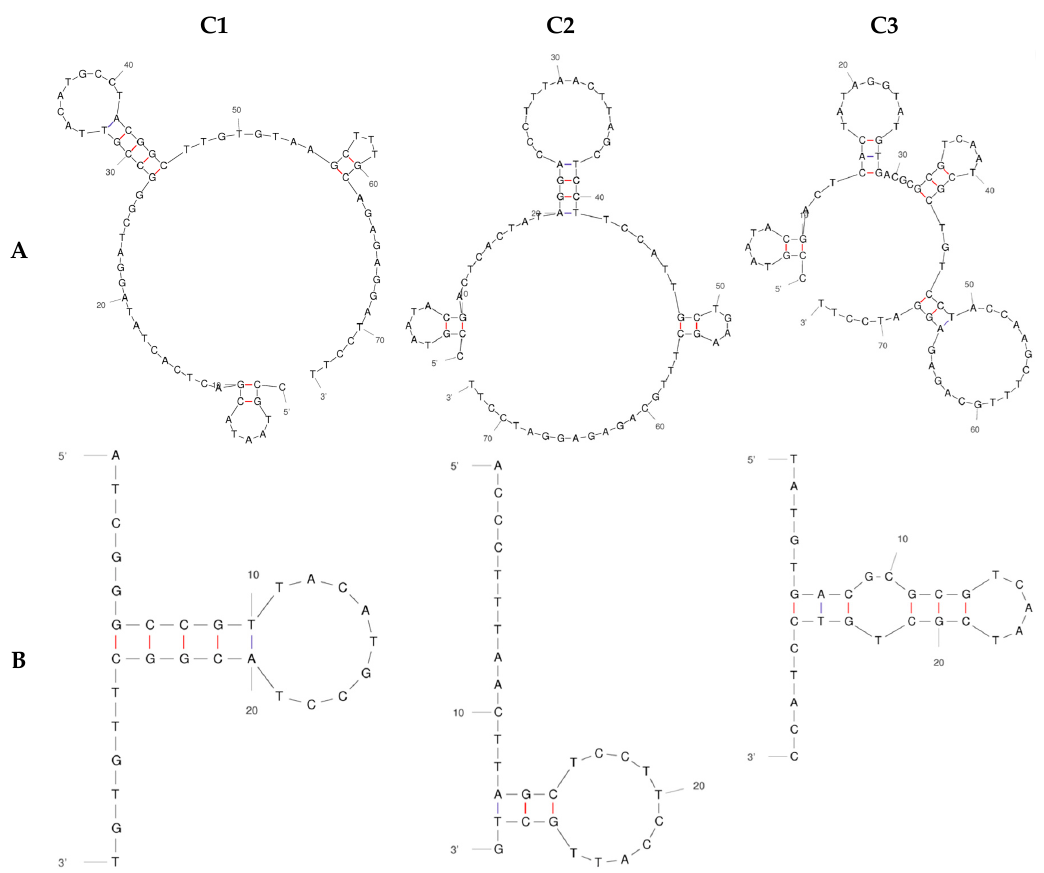
Figure 2. Predicted 2D secondary structures for C-lobe aptamers using mFold software comparing full length ( A ) with variable region ( B ) simulated at 150 mM NaCl and 25 °C.